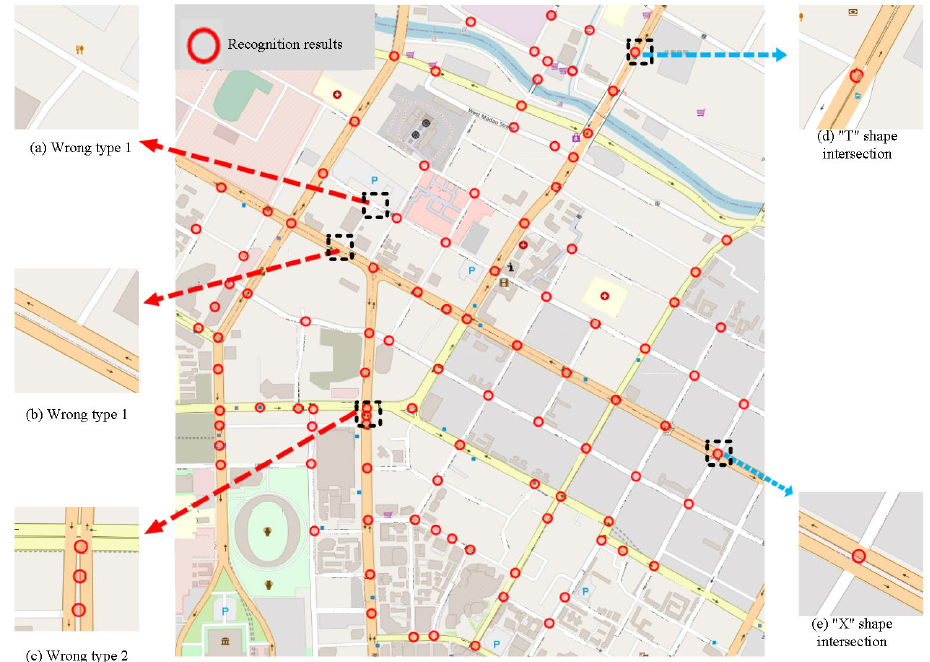
Figure 9. The road intersections detected by the proposed method in the experimental area.